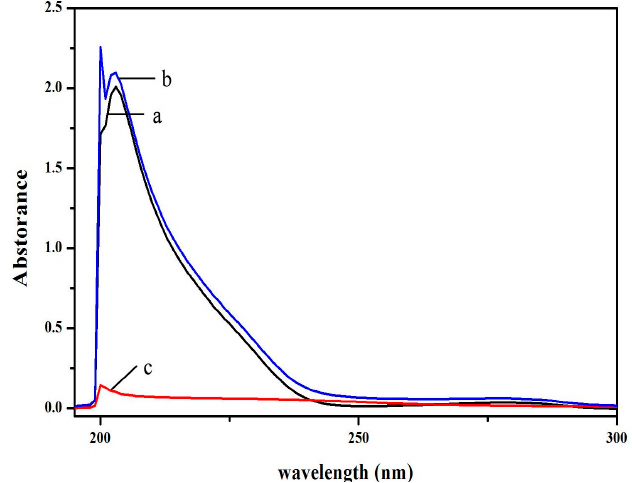
Figure 7. The effect between V 18 and bovine serum albumin (BSA). UV-Vis spectra of (a) 1.25 μ M BSA, (b) V 18 -BSA with molar ratio of 1:1, and (c) 1.25 μ M V 18 .